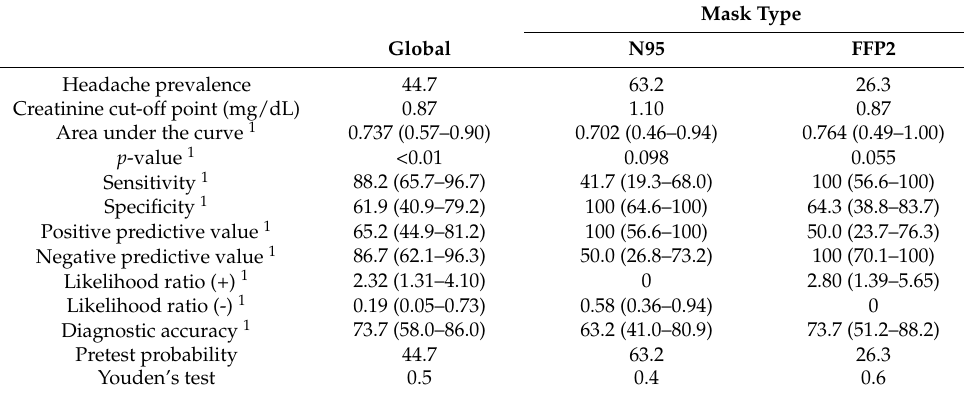
Table 4. Measures of the predictive models for creatinine and